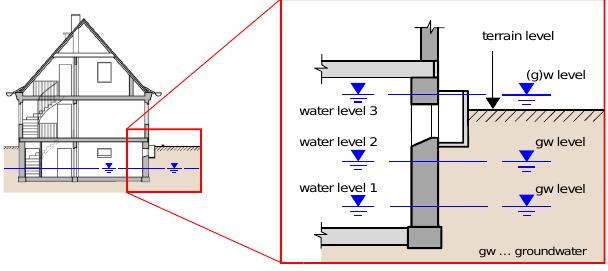
Fig. 4. Synthetic flooding in stages due to groundwater